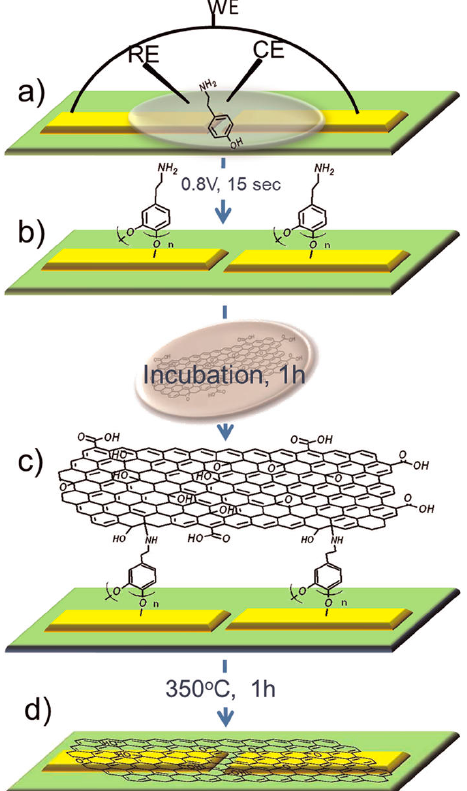
Figure 6. Scheme of the chemical anchoring protocol: ( a ) electrochemical functionalization of Pt electrodes with tyramine; ( b ) coating with polytyramine on the electrode surface; ( c ) incubation of the chip in a Graphene oxide (GO) solution; ( d ) annealing in argon at 350 °C. WE = working electrode, CE = counter electrode, RE = reference electrode (Reproduced with permission from [50]. American Chemical Society, 2012).